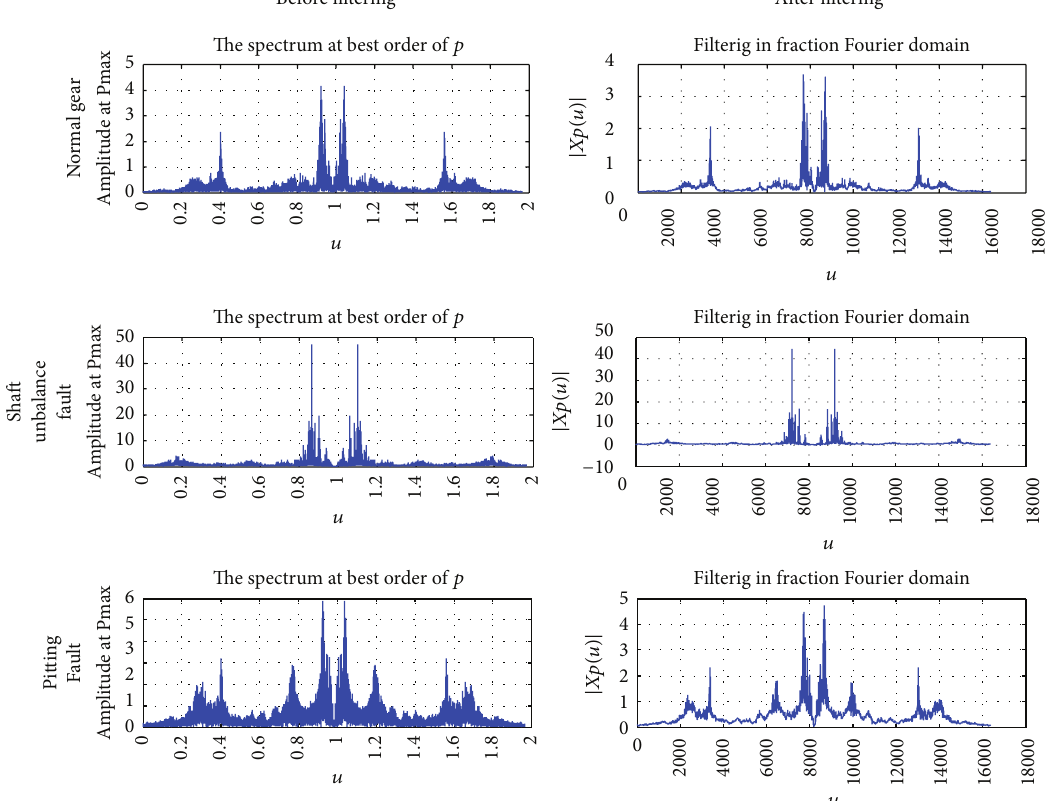
Figure 5: 2-dimensional distribution of signal energy before filtering and after narrow band filtering on fractional Fourier transform domain in three cases.